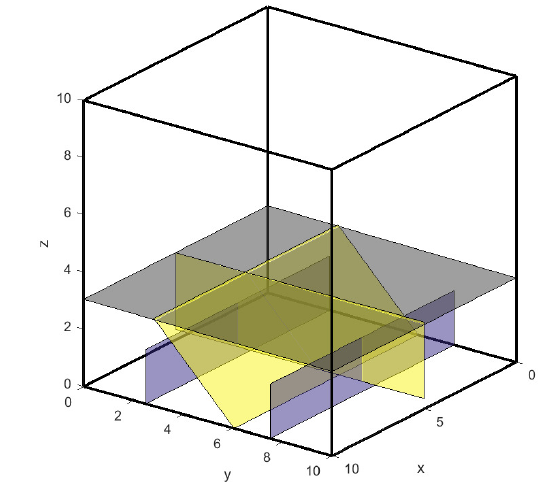
Figure 9. Three-dimensional fracture networks model in caprock for analyzing the CO 2 sequestration process (our large connected